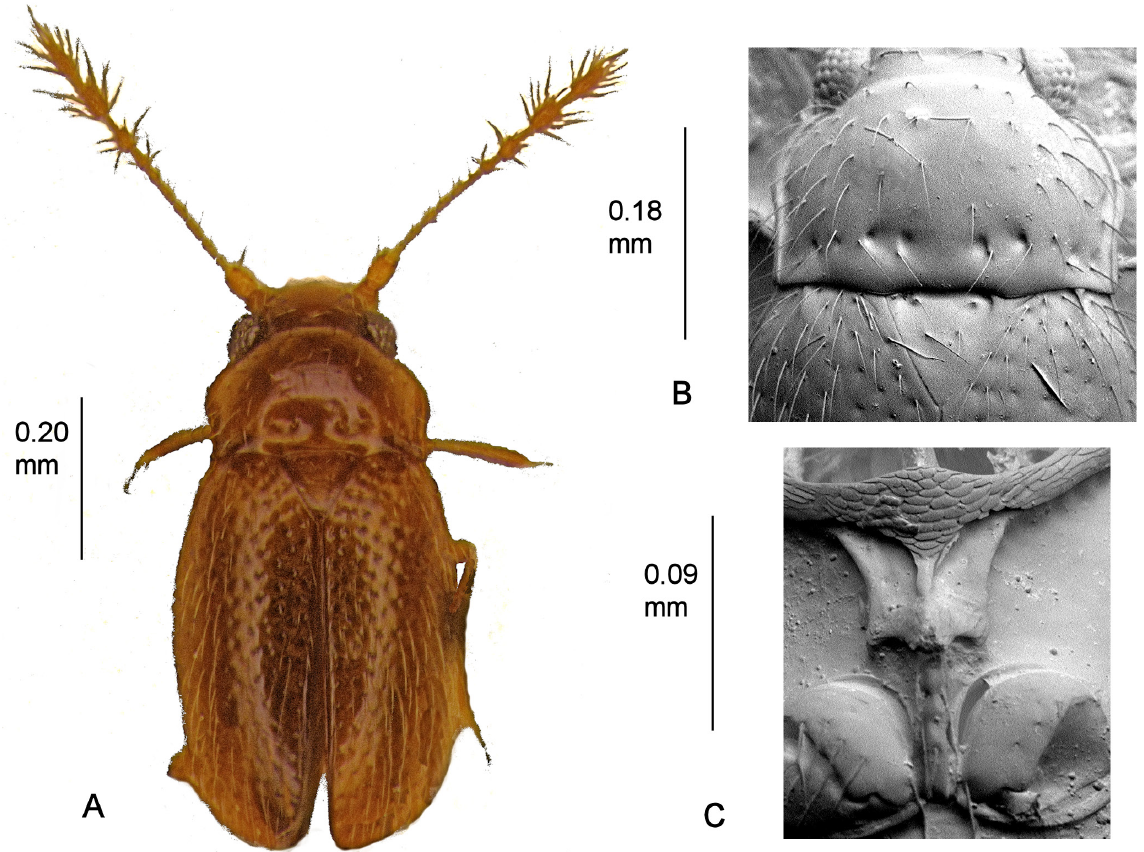
Fig. 30. Cissidium lamington sp. nov. A . Habitus. B . Pronotum, × 585. C . Mesoventrite showing median process of collar, mid-keel and keel, ×